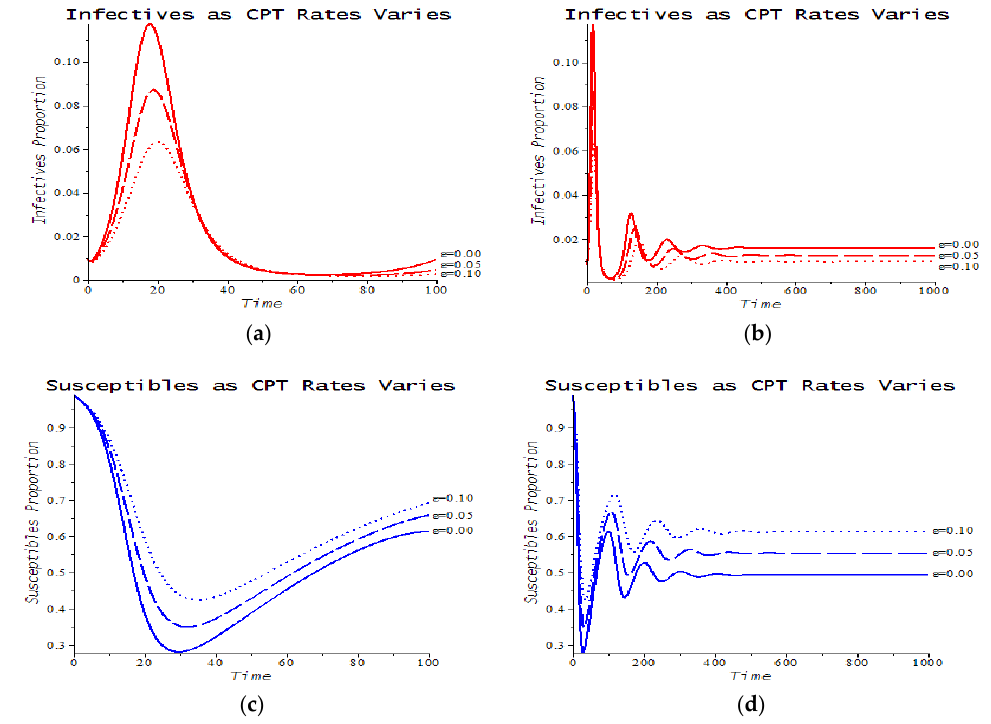
Figure 6. Graphs showing the effects of different rates of CPT on decreasing the number of infectives (i.e., lowering the height of the infective peaks) ( a , b ) and, consequently, increasing the number of remaining susceptibles ( c , d ). The other parameters were the same as in Figure 2.